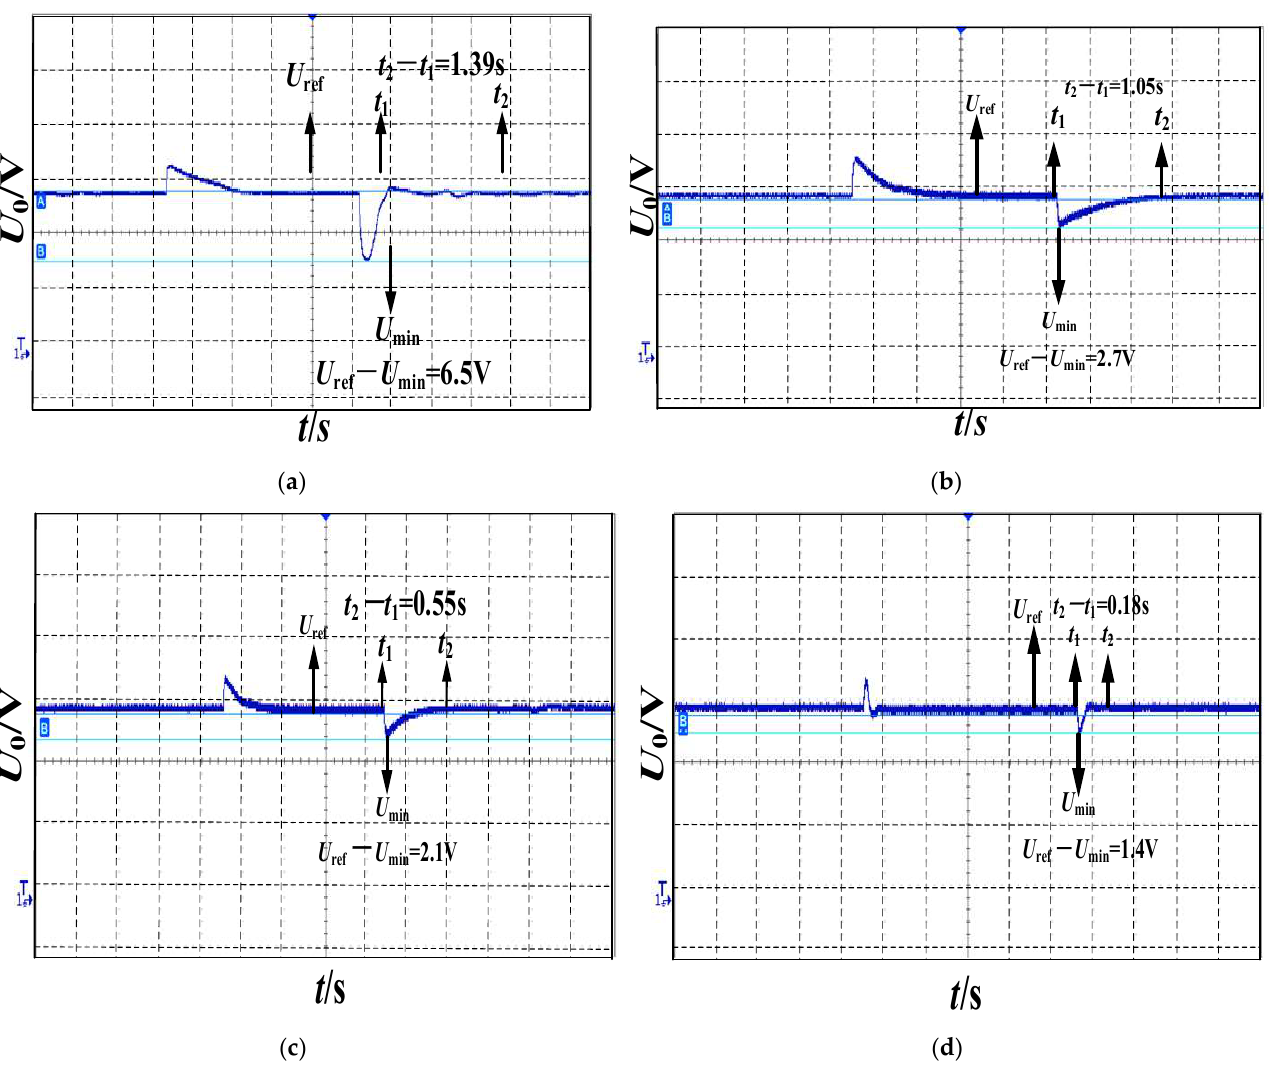
Figure 17. Output voltage of the DAB under different control strategies: ( a ) traditional double closed-loop control; ( b ) traditional VDCM control; ( c ) J and H adaptive VDCM control; ( d ) J , H, and R a adaptive VDCM control.